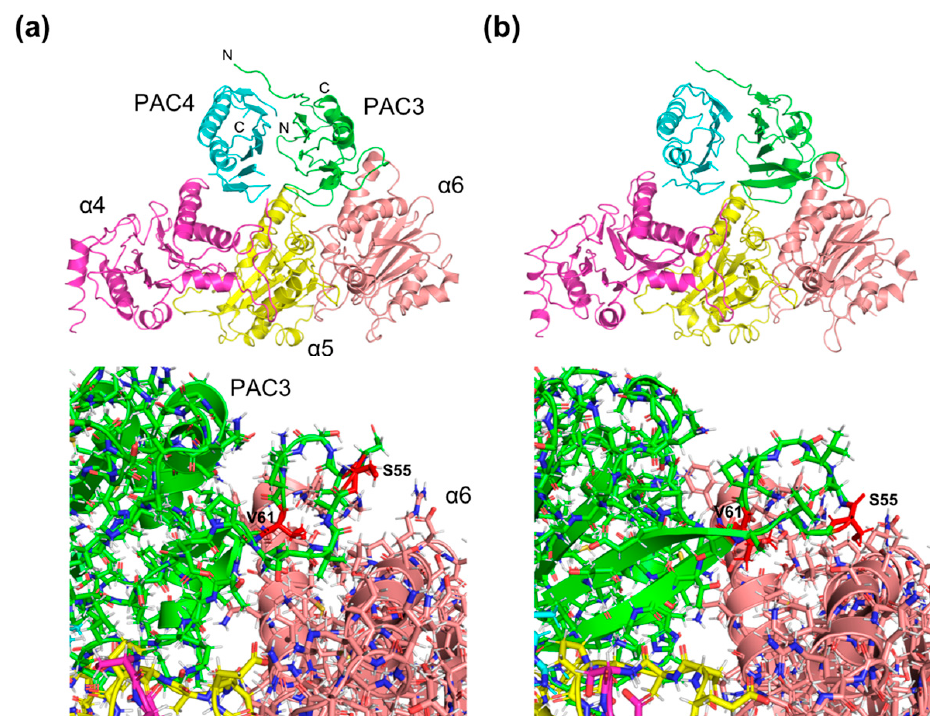
Figure 3. Three-dimensional model of the quintet complex comprising PAC3, PAC4, α 4, α 5, and α 6. ( a ) Complex model A, based on the 2.00-Å PAC3 structure. ( b ) Complex model B, based on the newly-determined 0.96-Å structure. The positions of the N- and C-termini are indicted. Overall and close-up views between PAC3 and α 6 of the quintet-complex models are shown in the upper and lower parts of the figure, respectively. Putative α 6-binding residues of PAC3, Ser55 and Val61 (see also Figure 4b), are highlighted in red in both models to highlight the conformational di ff erences of the loop between the two